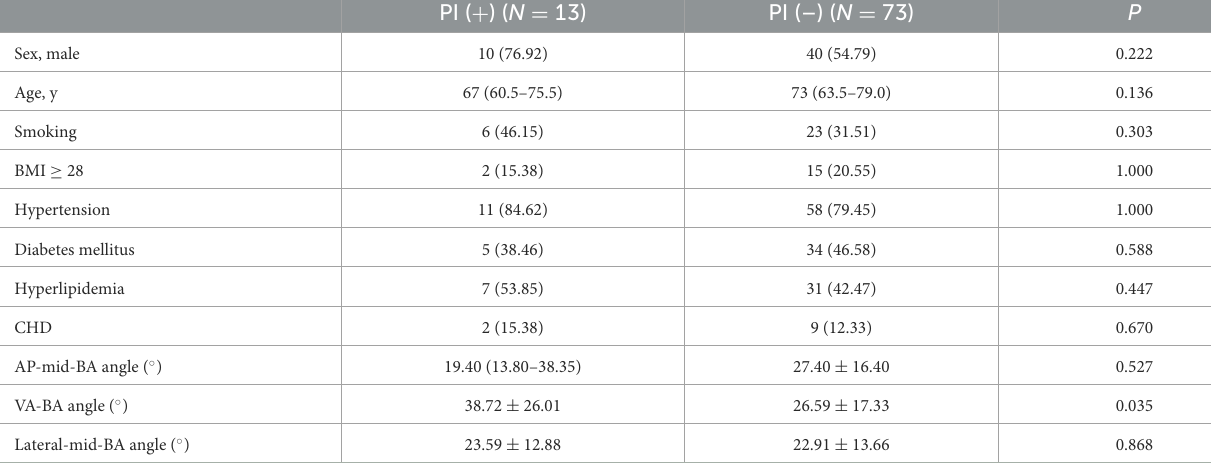
TABLE 2 Comparisons of clinical risk factors between patients with PI and without PI.